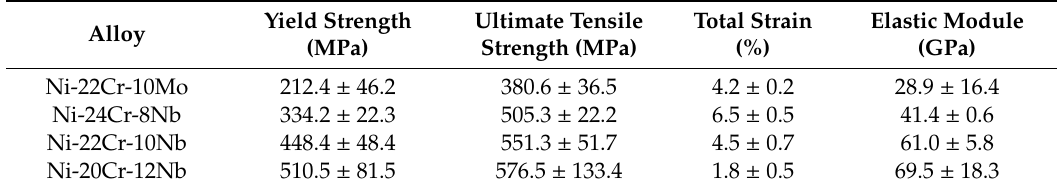
Figure 5. Representative tensile σ - ε curves of the as-cast Ni-Cr-Mo and Ni-Cr-Nb alloys investigated in this work. Table 5. Tensile mechanical properties of the as-cast Ni-Cr-Mo and Ni-Cr-Nb alloys evaluated in this work.